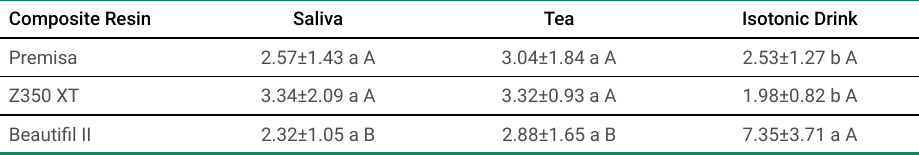
*Capital letter indicates statistical difference among columns. Lowercase indicates statistical difference among lines.